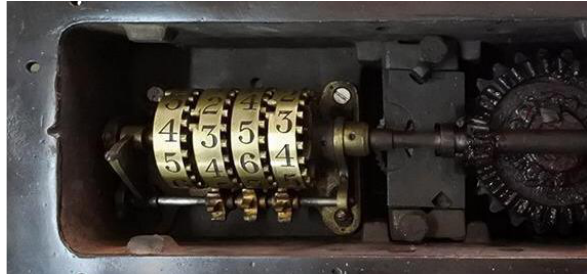
Figure 11. Cordillera elevator turnstile